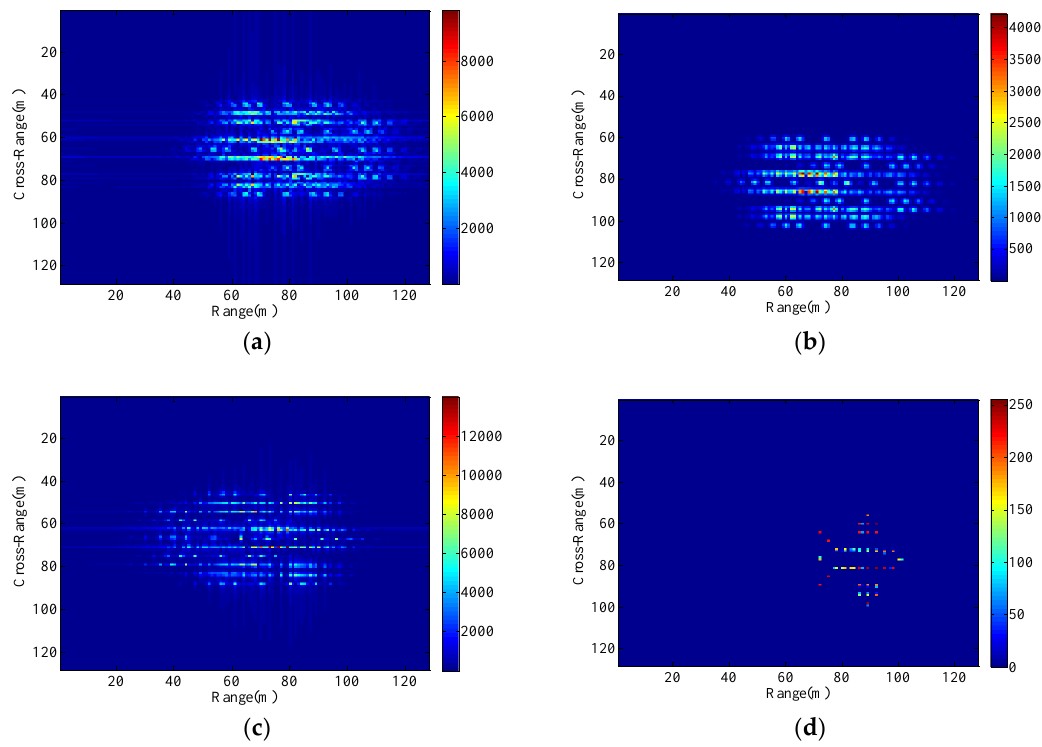
Figure 12. Imaging results with the radar platform vibration parameters P7. ( a ) RD algorithm; ( b )